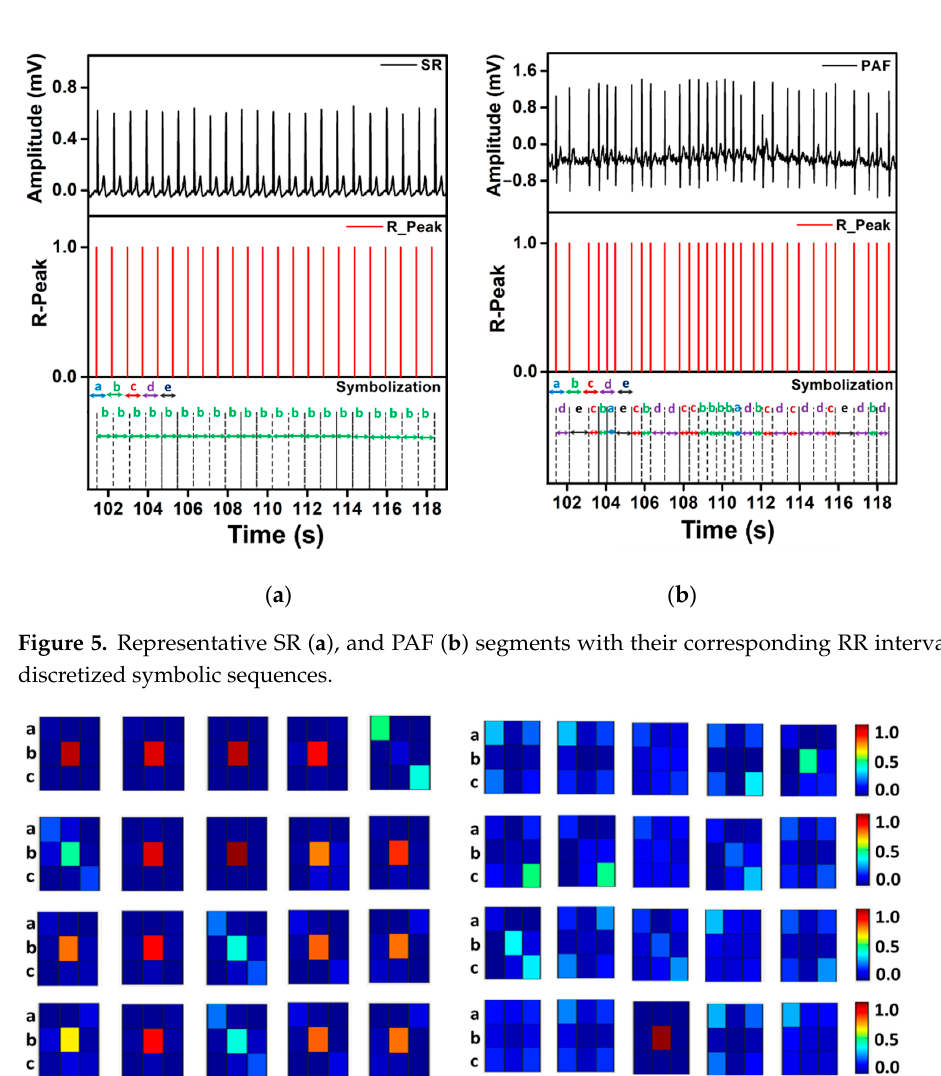
Table 4. Overall average performance (%) of the DSA method on the various databases using |𝕍| = 7 with varied 𝑊 . Bold values indicate the best performance in a group. for | V | = 3. The DSA feature for varied W with | V | = 3 in AFPDB and is shown in Figure 7c,d. The higher value of the DSA feature indicates the presence of a similar pattern in the segments. The median is higher for SR segments and ranges from 0.5 to 0.75 for both databases. The mean decreases with higher values of W. The